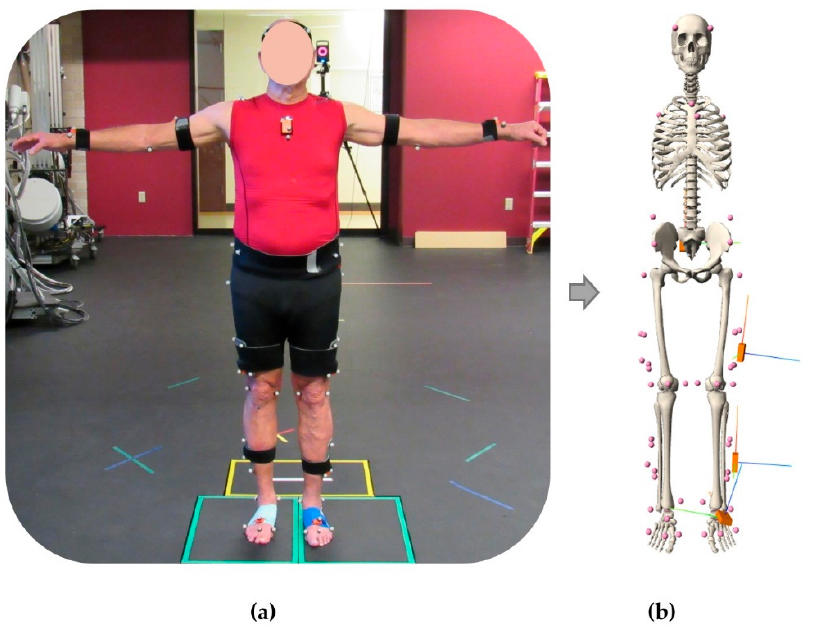
Figure 2. Subject fitted with reflective markers and inertial measurement units ( a ) and the corre- sponding musculoskeletal model representation with the virtual IMU sensors ( b ).